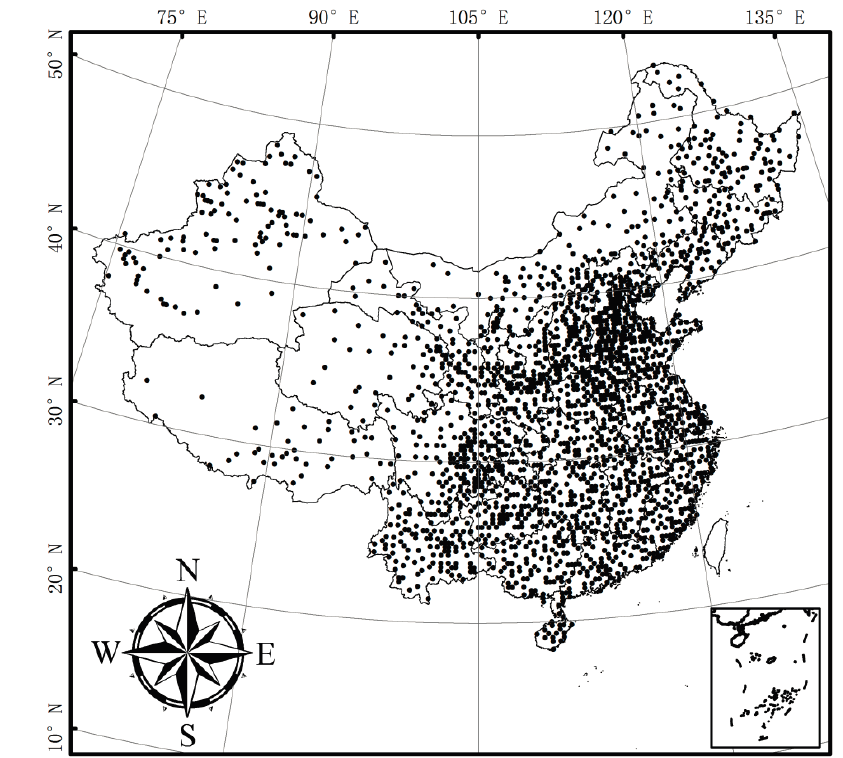
Figure 1. Distribution of rain gauge